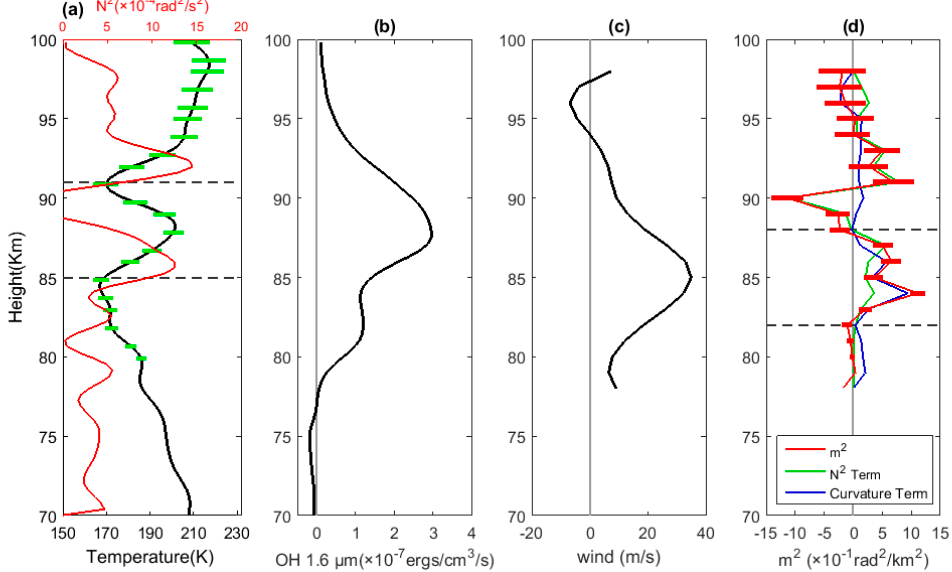
Figure 8. The height profile of ( a ) temperature and N 2 (red line) at 22:16 LT, and ( b ) the average 1.6 µ m OH emission intensity observed by SABER at 22:14 LT, 22:15 LT, 22:16 LT and 22:17 LT on 10th August. The green error bars are the RSS uncertainties. ( c ) Average height profile of the meteoric wind in the direction of CGW propagation at the Beijing station (39.98° N, 116.37° E) from 21:00 LT to 23:00 LT on 10th August. ( d ) The profile of the squared vertical wavenumber m 2 is calculated by the ( a ) N 2 term and ( c ) wind; the green ( N 2 term) and blue (curvature term) lines are the first term and second term in Equation (3). The deviations (red error bars) are propagated by the temperature. The squared vertical wavenumber m 2 is a criterion for the vertical propagation of GWs. In the layer where m 2 is positive, surrounded by evanescent regions (where m 2 is negative), the structure